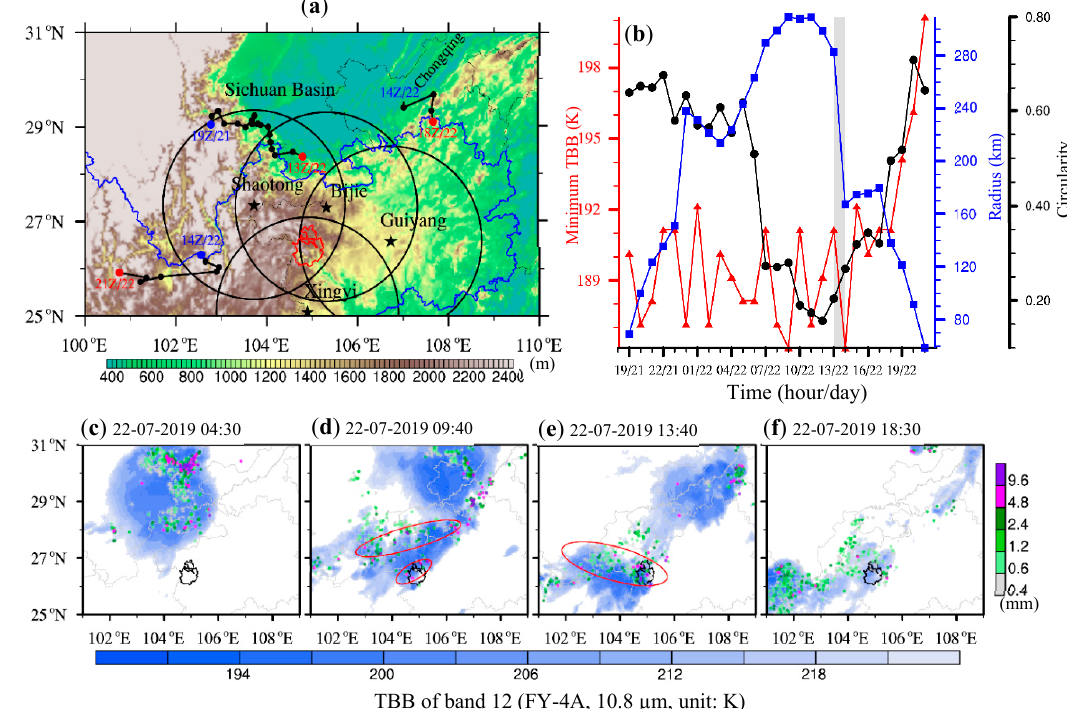
Figure 3. ( a ) The locations and propagations of mesoscale convective systems (MCSs) over Southwest China. The MCS centroids are denoted by solid circles with accompanying time labels (hour/day UTC); the blue spots represent onset locations, and the red spots represent dissipation locations. The locations of the four radars are denoted by solid stars; the radius of the range rings is 200 km. The Yunnan–Guizhou Plateau area is outlined with a blue line, and Shuicheng County is outlined with a red line. ( b ) The minimum blackbody brightness temperature (TBB), radius, and circularity evolution of the MCSs. The gray shaded area represents the moment the MCSs split. ( c – f ) The infrared images of TBB observed by the FY-4 satellite and overlaid by the future 10 min accumulated precipitation. The colored dots represent different levels of precipitation, and the red circles denote the rainfall bands.